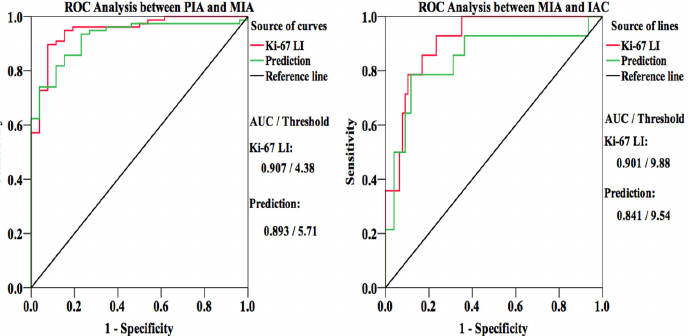
Fig 8. Receiver operating characteristic (ROC) curves of predictive Ki-67 labeling index (LI) and actual Ki-67 LI for comparison. Area under the curve (AUC) of predictive Ki-67 LI was lower than actual measured one, but